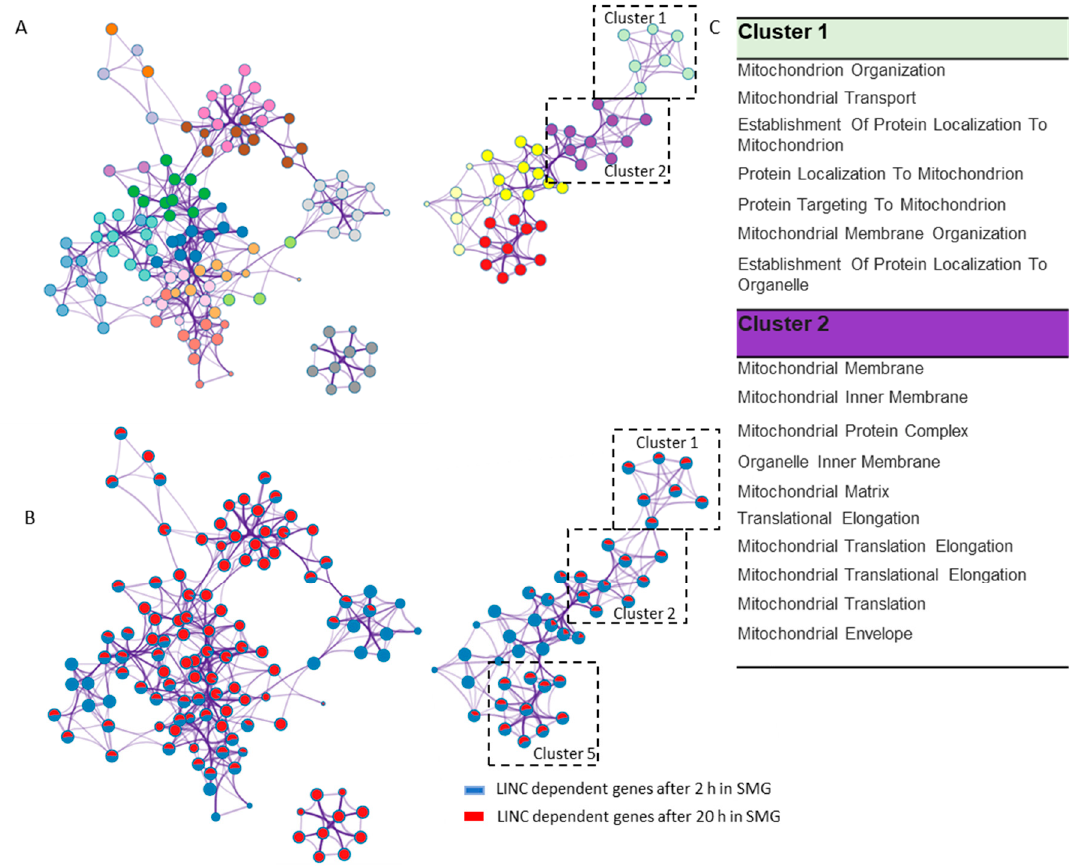
Figure 4. Network of top 20 clusters of the enriched terms. ( A ) Network representing each cluster by a different color; ( B ) network enrichment shown with pie chart. The size of the pie in each node depends on the gene count of the two conditions. Red indicates enrichment of pathways due to LINC-dependent genes at 20 h of SMG, and blue indicates enrichment of pathways in LINC-dependent genes at 2 h of SMG. ( C ) Enriched terms in Clusters 1 and 2 are all linked to mitochondria.